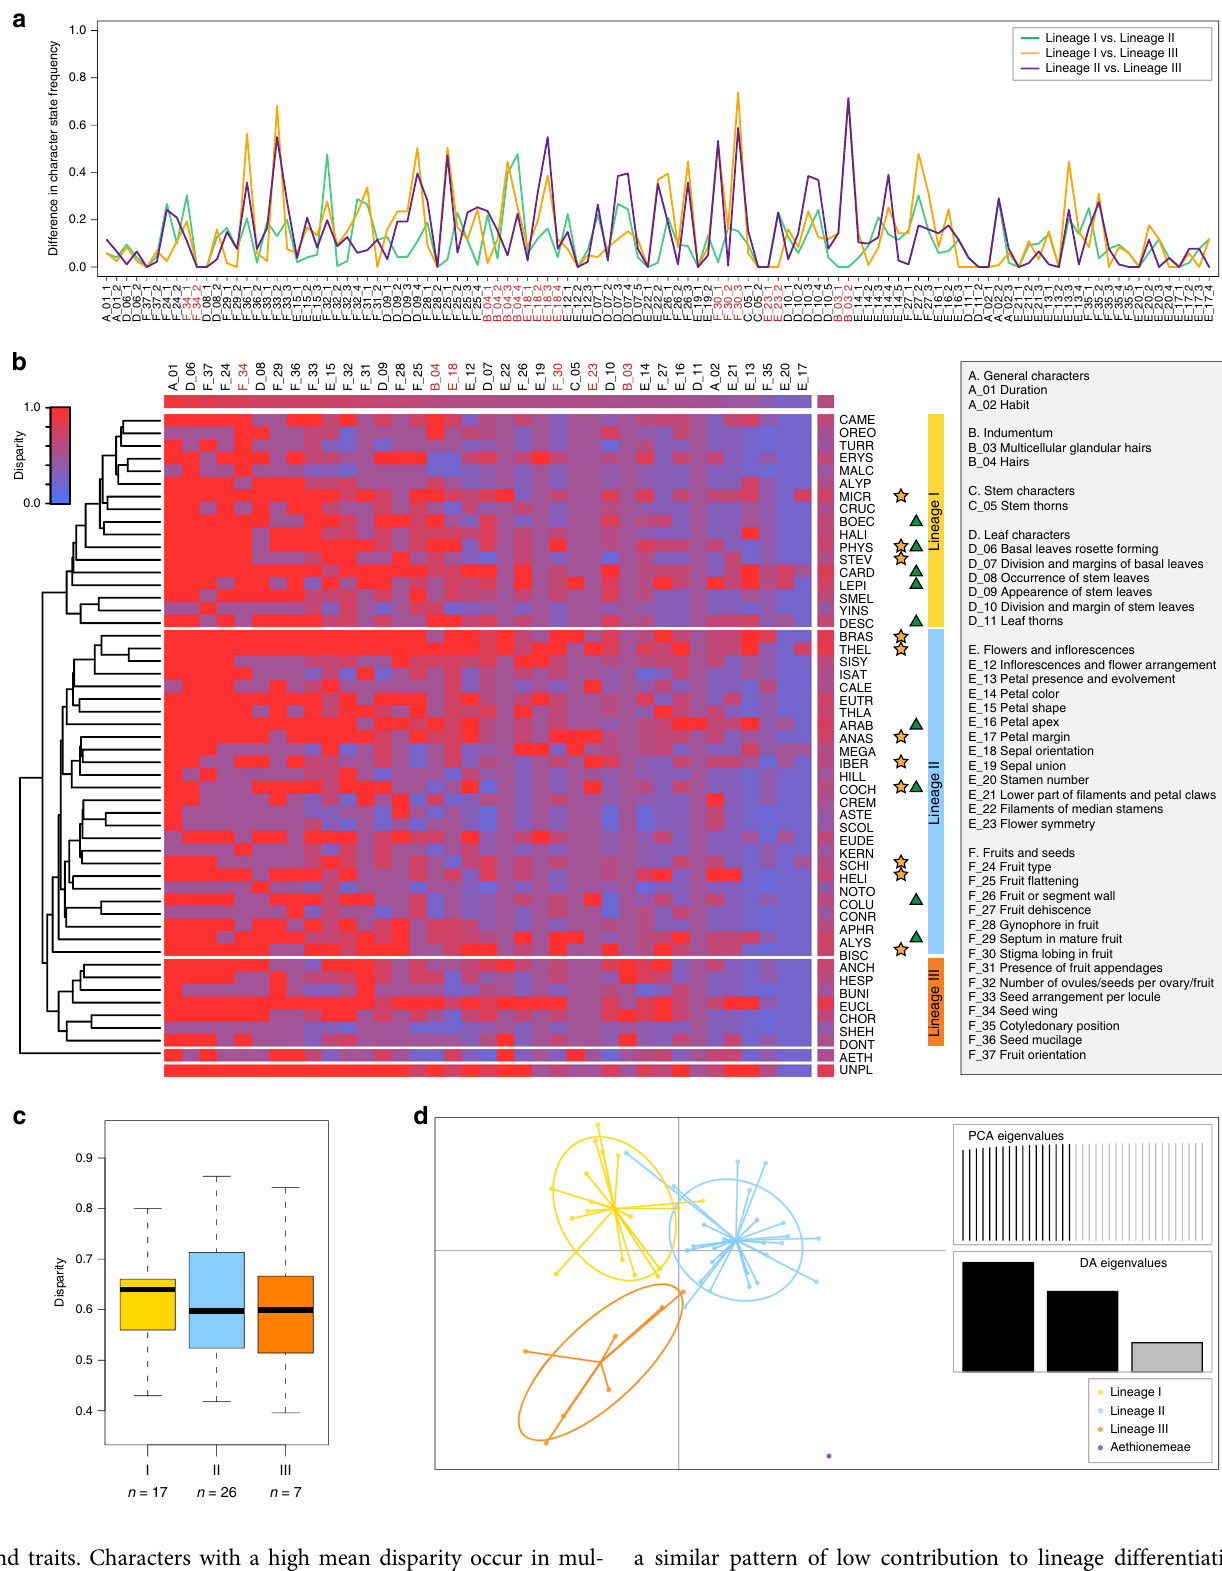
a similar pattern of low contribution to lineage differentiation, low pairwise differences and lack of phylogenetic signal. In con- trast, those characters showing phylogenetic signal in disparity, high pairwise differences between character state frequencies and high contribution to lineage differentiation have medium levels of disparity. Key innovations after WGDs, such as the emergence of glucosinolates in Brassicales 21 or the pentamerous fl ower